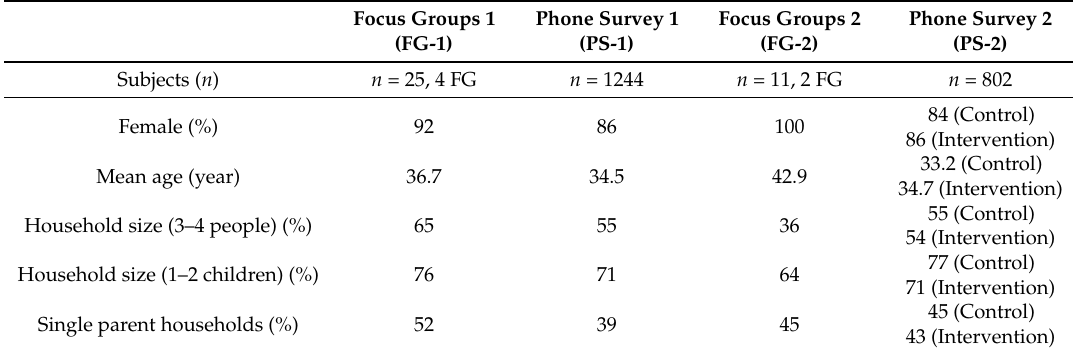
Table 3. Food Hero Formative Evaluation: Focus Group (FG) and Phone Survey (PS)